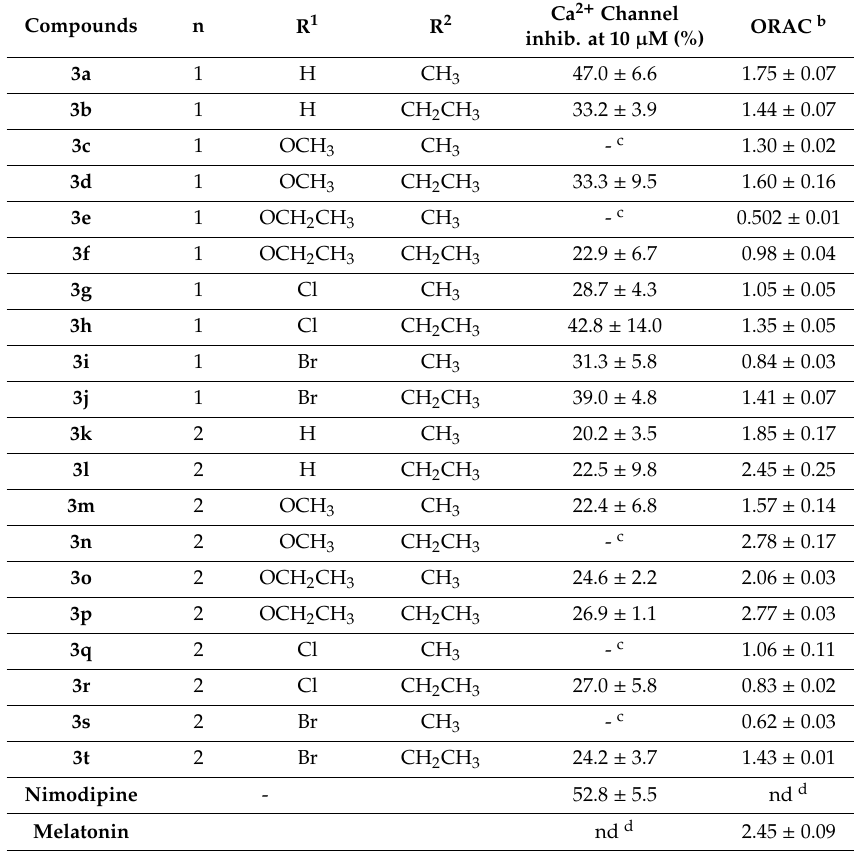
Table 1. Calcium blockade percentages for compounds 3a – t , expressed in percentage of inhibition at 10 µ M, and their ORAC (TE) values.